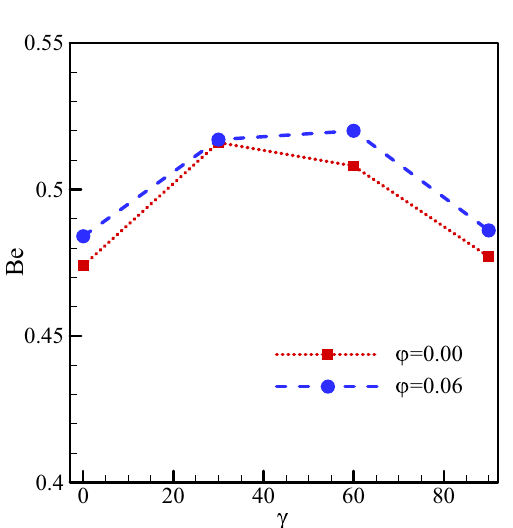
Figure 16. Average Nusselt number at the warm surface for Ra = 10 5 , ω = 0, Ha = 20, Rd = 1 and various nanofluid concentrations and cavity angles.